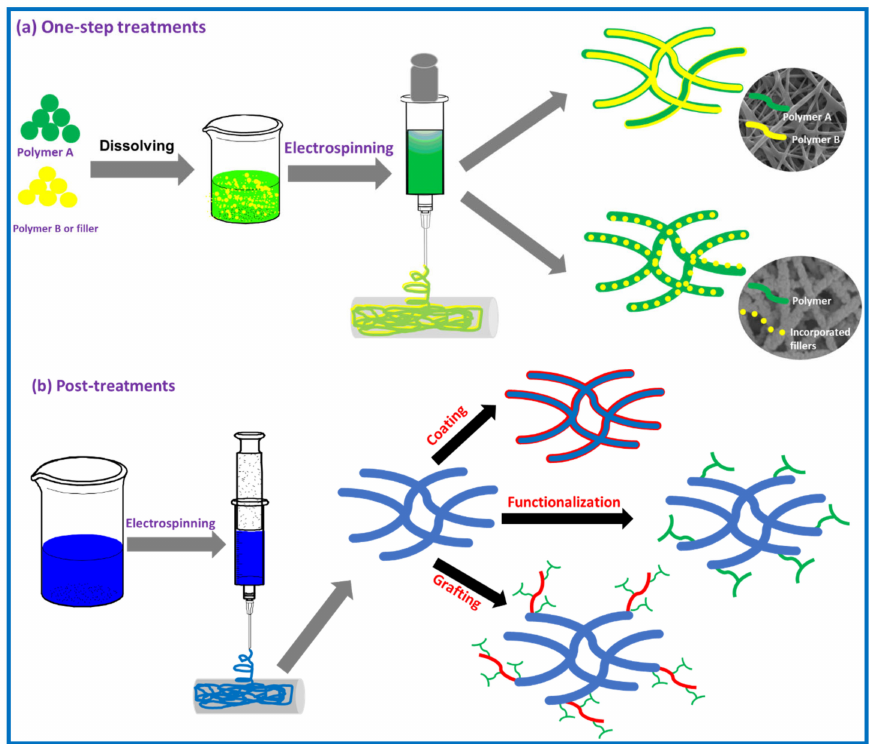
Figure 2. Surface modification of electrospun polymer